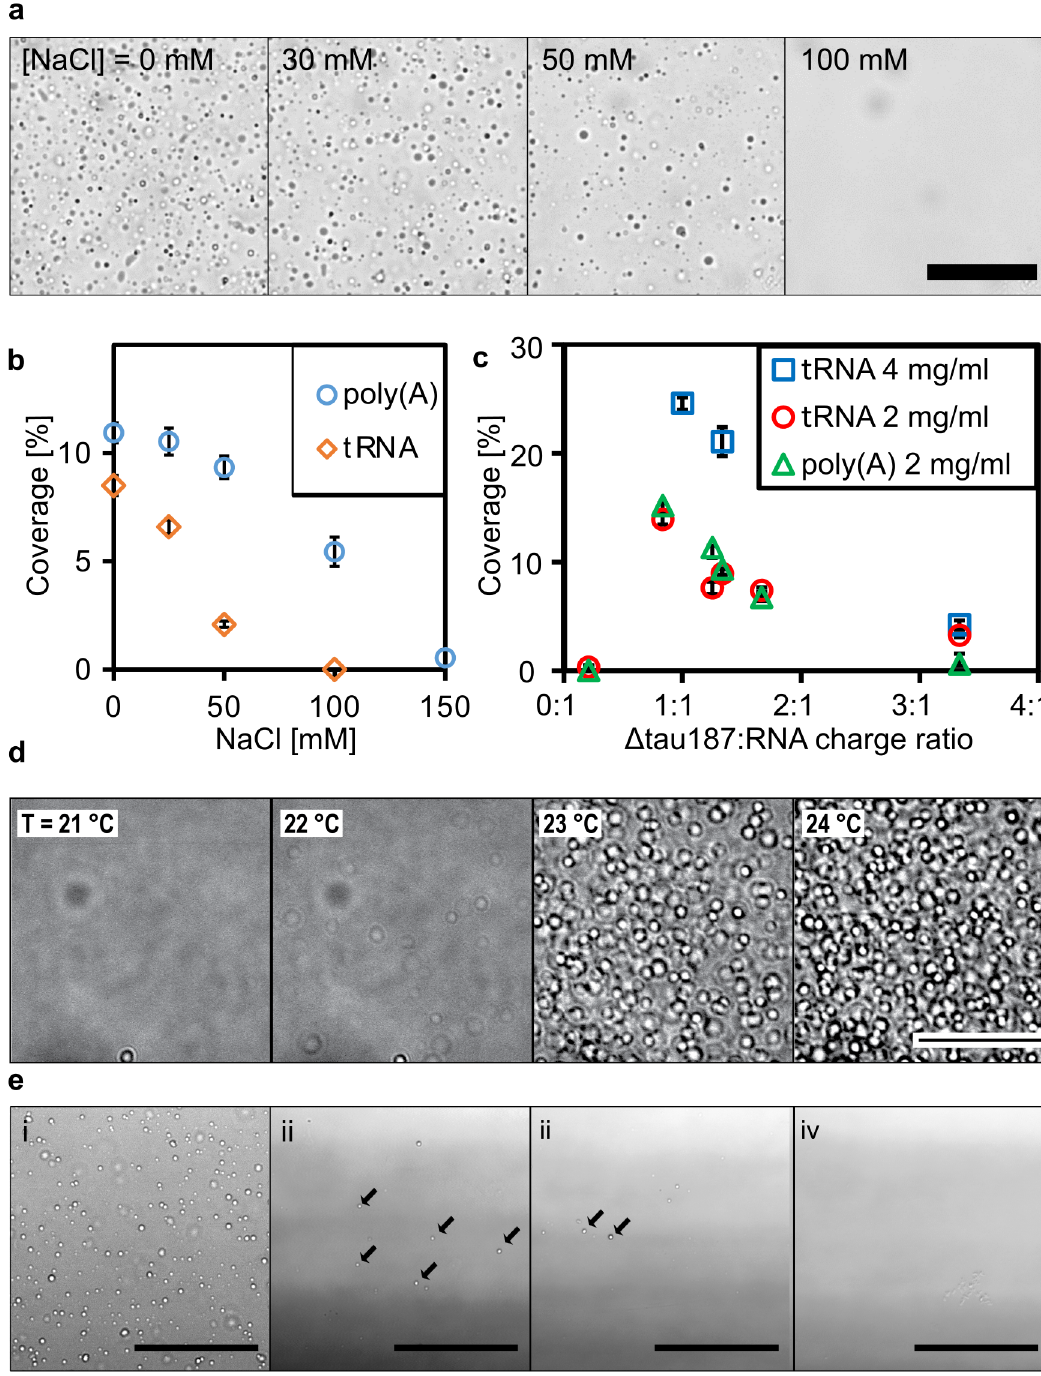
Fig 5. Tau-RNA droplets form a complex coacervate phase. (A) Representative bright-fieldimages of tau-tRNA droplet samples at room temperature with varying[NaCl]. (B) Droplet coverage(in %) with poly(A) or tRNA in room temperature with varying [NaCl]. Δ tau187:RNA in (A) and (B) were maintained at a mass ratio of 7:1 (correspondingto a charge ratio of 1.2:1) and a total mass concentration of 2 mg/ml. (C) Droplet coveragewith poly(A) or tRNA with varying Δ tau187:RNA charge ratios. The total mass concentrations are indicatedin the legends. Samples made by mixing of 80 μ M Δ tau187with 222 μ g/ml poly(A)/tRNA or 161 μ M Δ tau187with 444 μ g/ml tRNA gave the highestdroplet coverage(%), which correspond to chargeratio of 1.3–1.2 betweentau and RNA. Error bars in (B) and (C) represent the standarddeviationfrom n = 3. (D) Representative bright-fieldimages of tau-RNA droplets as a function of incubationtemperature. To record these